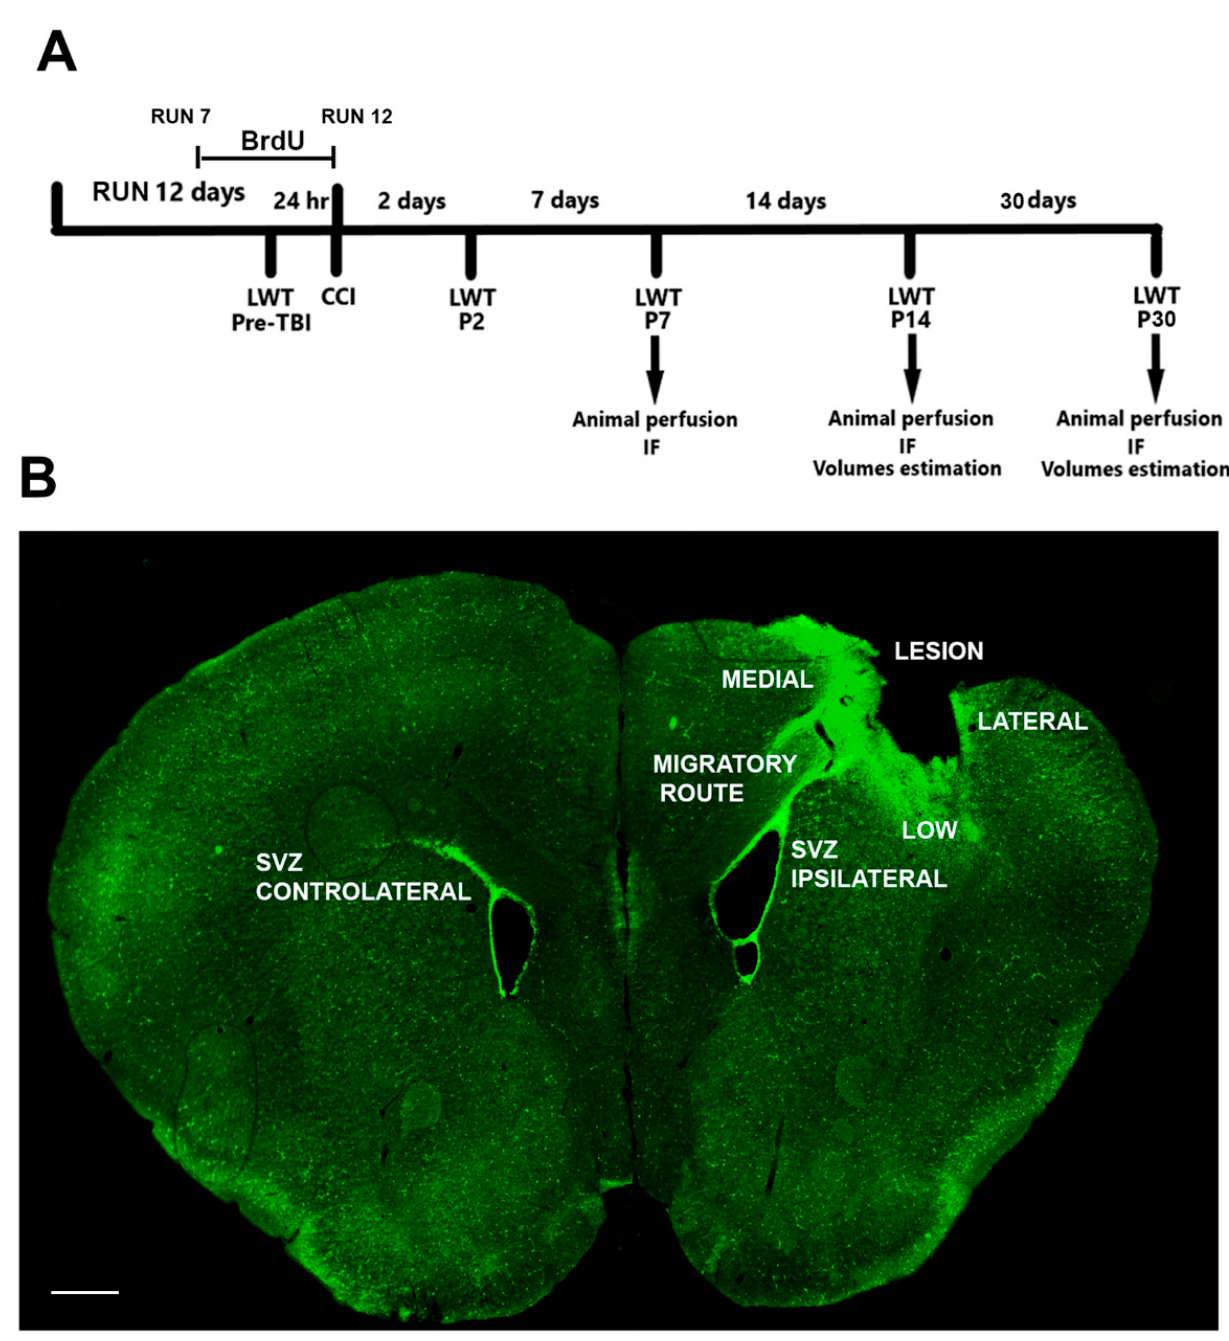
Figure 1. Graphical representation of experimental procedures. ( A ) Experimental timeline. The animals have been subjected to a running session for 12 days. From day 7 of the running session until the day of the lesion, BrdU is administered in the drinking water of the animals. On the 12th day, the mice undergo the CCI surgical procedure. The functional outcome has been evaluated by the Ladder Rung Walking Task (LWT) 24 h before CCI (pre-TBI) to determine the baseline number of errors, and two, seven, fourteen and thirty-three days after the surgery (P2, P7, P14 and P30). At P7, P14 and P30, the animals have been sacrificed to perform immunofluorescence assays (IF). ( B ) Coronal section of a lesioned brain. To evaluate the cellular processes that occur in the brain after the trauma, we considered the following: the ipsi- and contralateral SVZ, the migratory route and the low, medial and lateral sides of the lesioned cortex. Scale bar = 400 µ